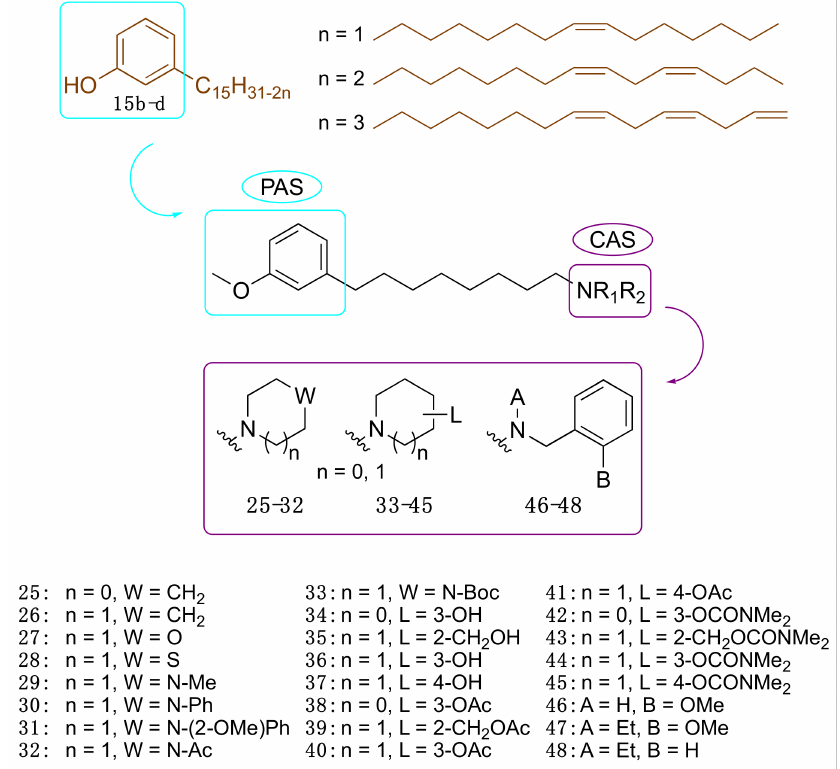
Figure 7. Cardanol-derived AChE inhibitors 25 – 48